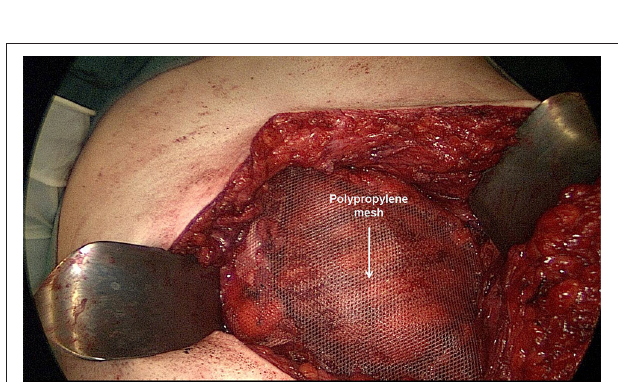
FIGURE 8 | Closure of the posterior rectus sheath cranially.